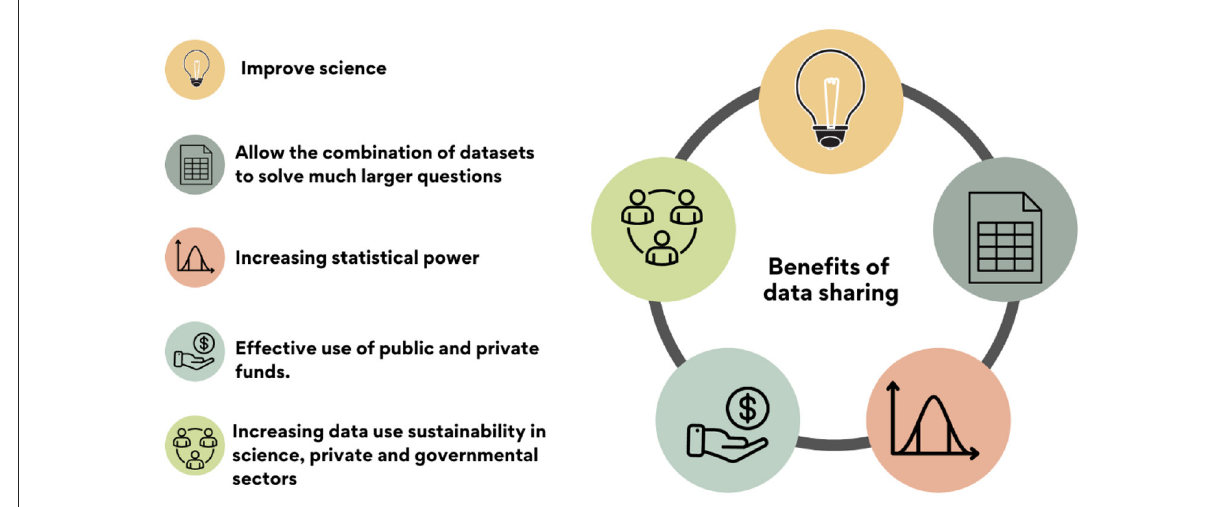
FIGURE1 Benefits of data sharing under FAIR principle, based on Perrier et al.